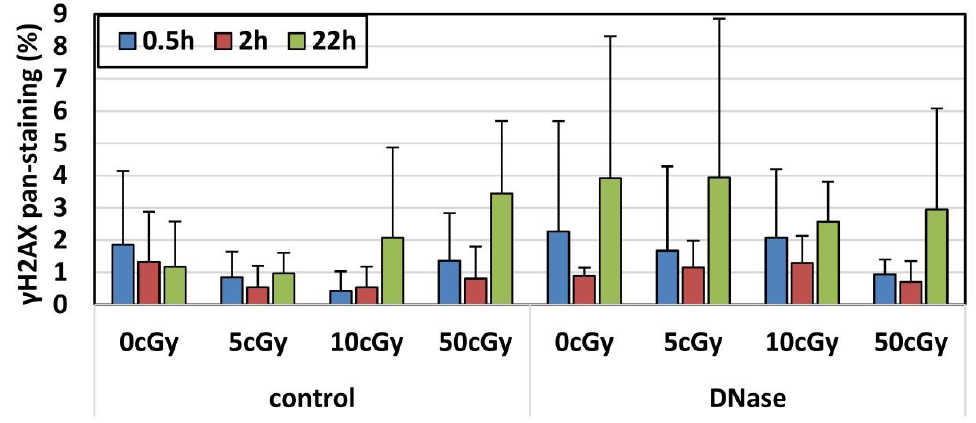
Figure 2. The level of γ H2AX foci (A), 53BP1 foci (B), and co-localized γ H2AX / 53BP1 foci (C) in the cells thawed with and without DNaseI. Cells were thawed with or without DNase irradiated with doses 0, 5, 10, and 50 cGy and immunostained 30 min, 2 h, and 22 h post-irradiation. Each data point shows the mean value and standard deviation from 3 experiments.